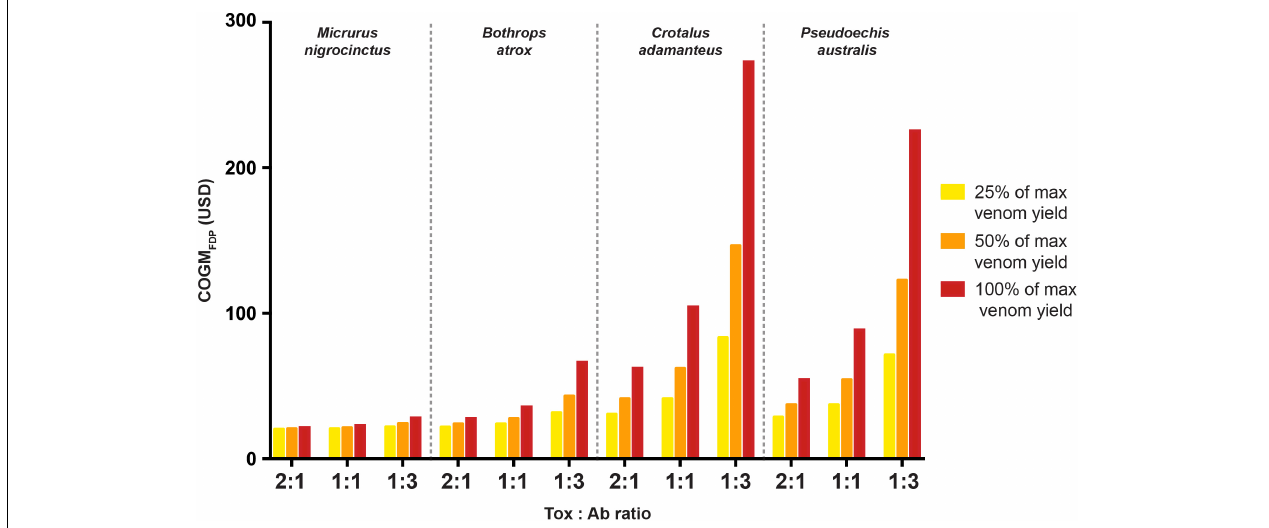
FIGURE 4 | Cost of monovalent recombinant antivenoms against four representative species of venomous snakes. The calculations were conducted for three different toxin-to-antibody ratios (i.e., 2:1, 1:1, and 1:3) and assumed that either 25% (yellow), 50% (orange), or 100% (red) of the maximum venom yield needs to be neutralized. The calculations are for Cost of Goods Manufactured for the Final Drug Product for a full treatment of a given snakebite (COGM FDP ) and, thus, include formulation and packaging